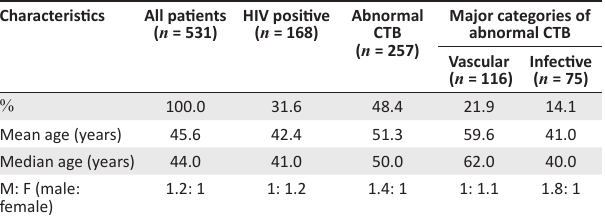
TABLE 1 : Demographic data of patients presenting with new-onset